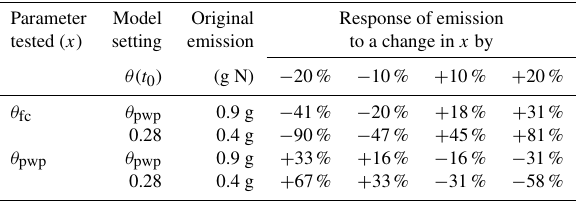
Table 6. Model results from model experiments with GAG_patch, testing the effect of the initial water content of the soil ( θ(t 0 )) on the model sensitivity to θ fc (field capacity) and θ pwp (permanent wilting point). Input data were applied from the baseline simulation with GAG_patch, except for θ fc and θ pwp , which were applied from the baseline simulation with GAG_field, and θ(t 0 ) , which was modified in the simulations as stated below. The sensitivity was expressed as a percentage difference in the original NH 3 emission (listed also in the table for every model